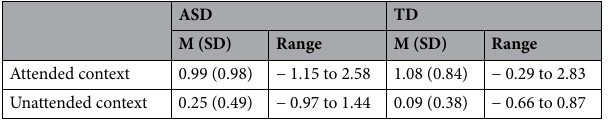
Table 4. Group averages in metamemory performance (metad’) for context